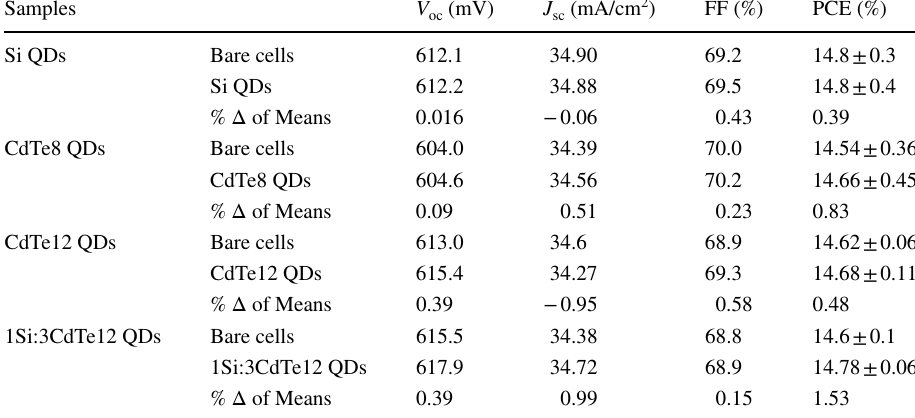
Table 4 Solar cell characterization